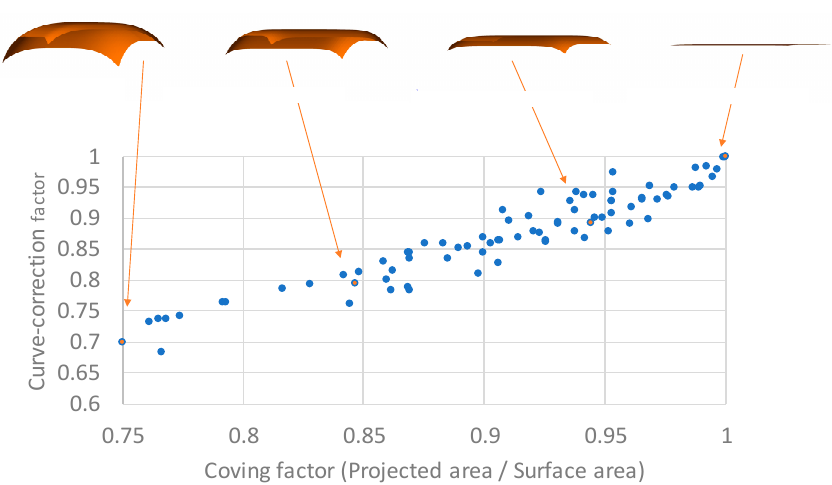
Figure 8. Curve correction factor vs. representative curve shape parameter (coving factor as f 1 ).